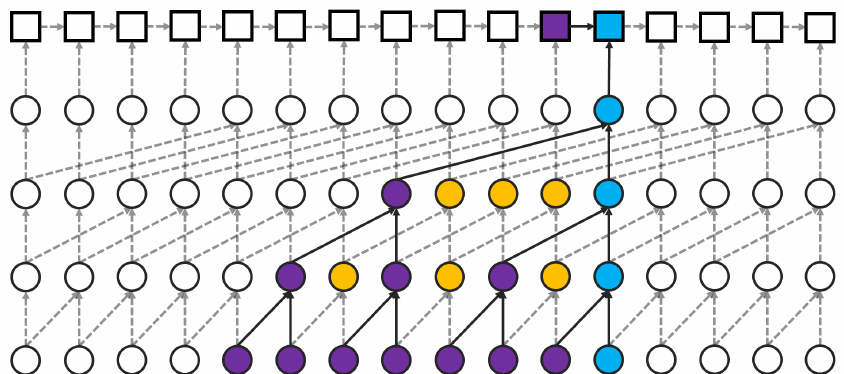
Figure 13. Memory usage process for TCN + LSTM (Note: Note: Purple denotes data used in the past and currently, yellow denotes memory to be stored for the future, and blue denotes the number of nodes in current operation).